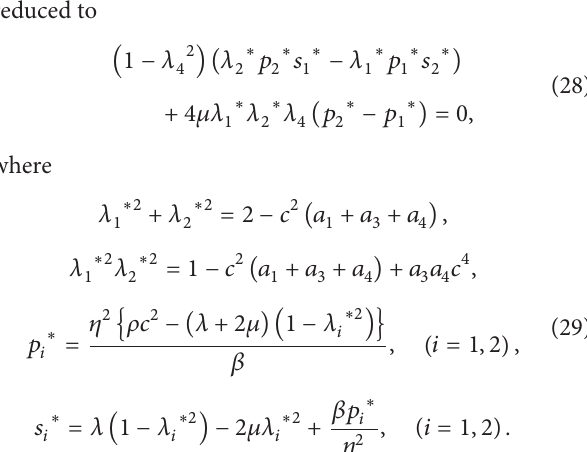
Figure 1: Variation of the nondimensional speed (𝜌𝑐 2 /𝜇) Rayleigh wave versus frequency 𝜒 .